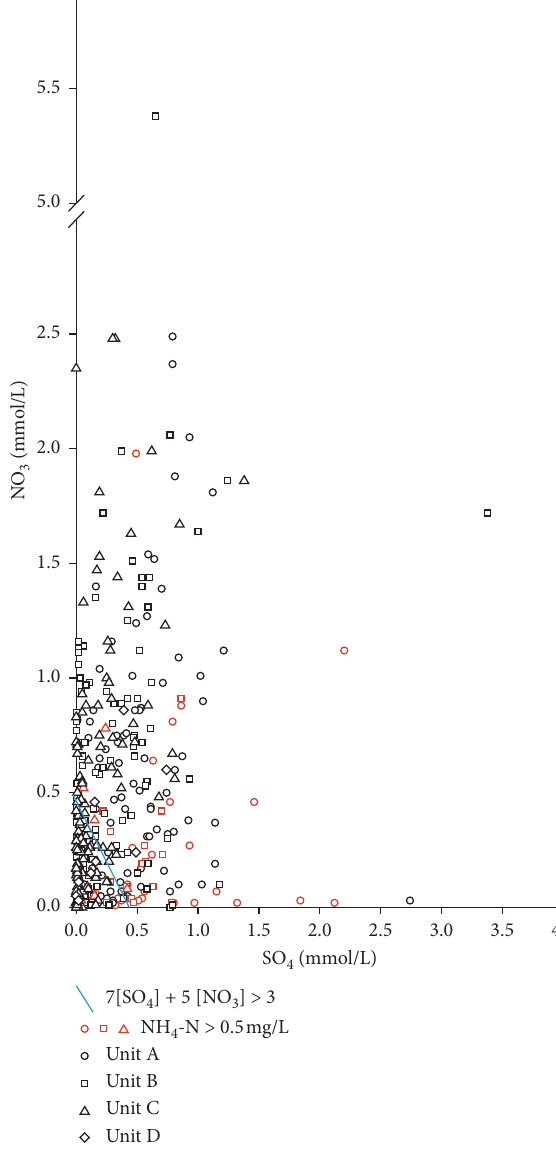
Figure 2: High levels of NH 4 as well as oxidation capacity in various groundwater units in the Pearl River